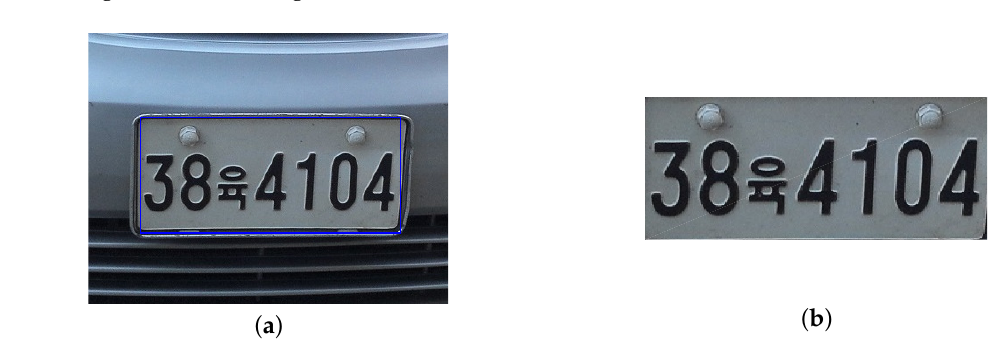
Figure 1. ( a ) Real and selected license plate image. ( b ) Selected grayscale image.